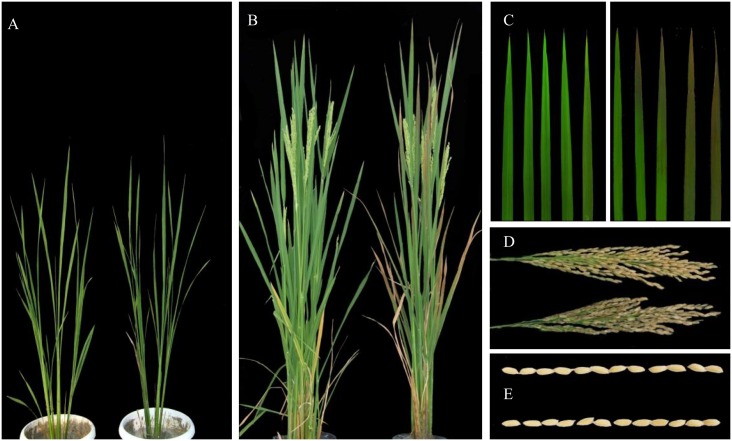
Comparison of plant morphological phenotypes between psf mutant and its wild type (Zhehui7954) at different growth stages, and the senescence of flag leaves after anthesis.(A) Tillering stage, left: wild type and right: psf mutant. (B) Grain filling stage, left: wild type and right: psf mutant (C) The senescent process of flag leaves for psf mutant (right) and wild type (left) from anthesis to 28 days after anthesis. (D) The panicle phenotype at mature stage, wild type (above) and psf mutant (below). (E) Grain shape, wild type (above) and psf mutant (below).